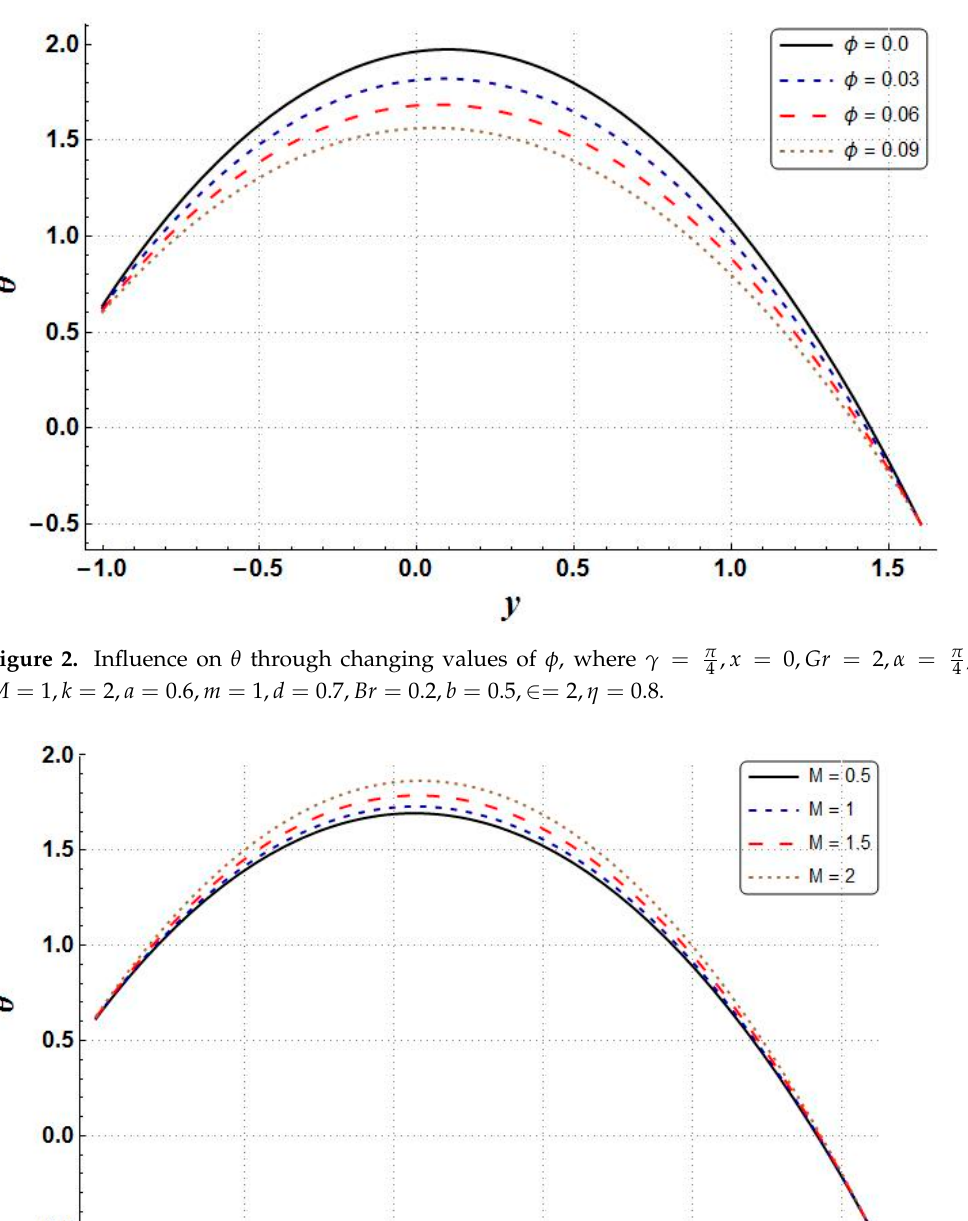
, x = 0, Gr = 2, α = π 4 M , where